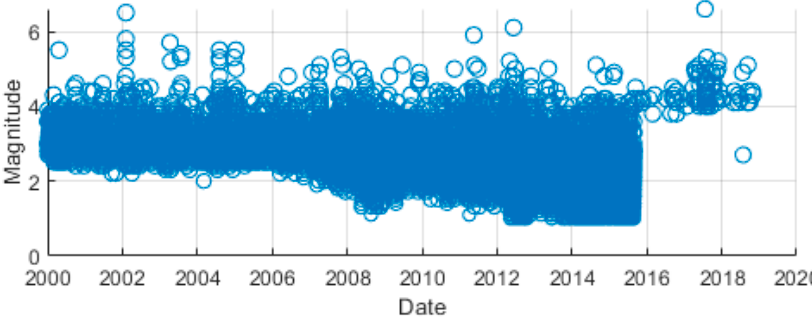
Figure 3. Distribution of earthquakes with their magnitudes from 2000 to 20 December 2018.